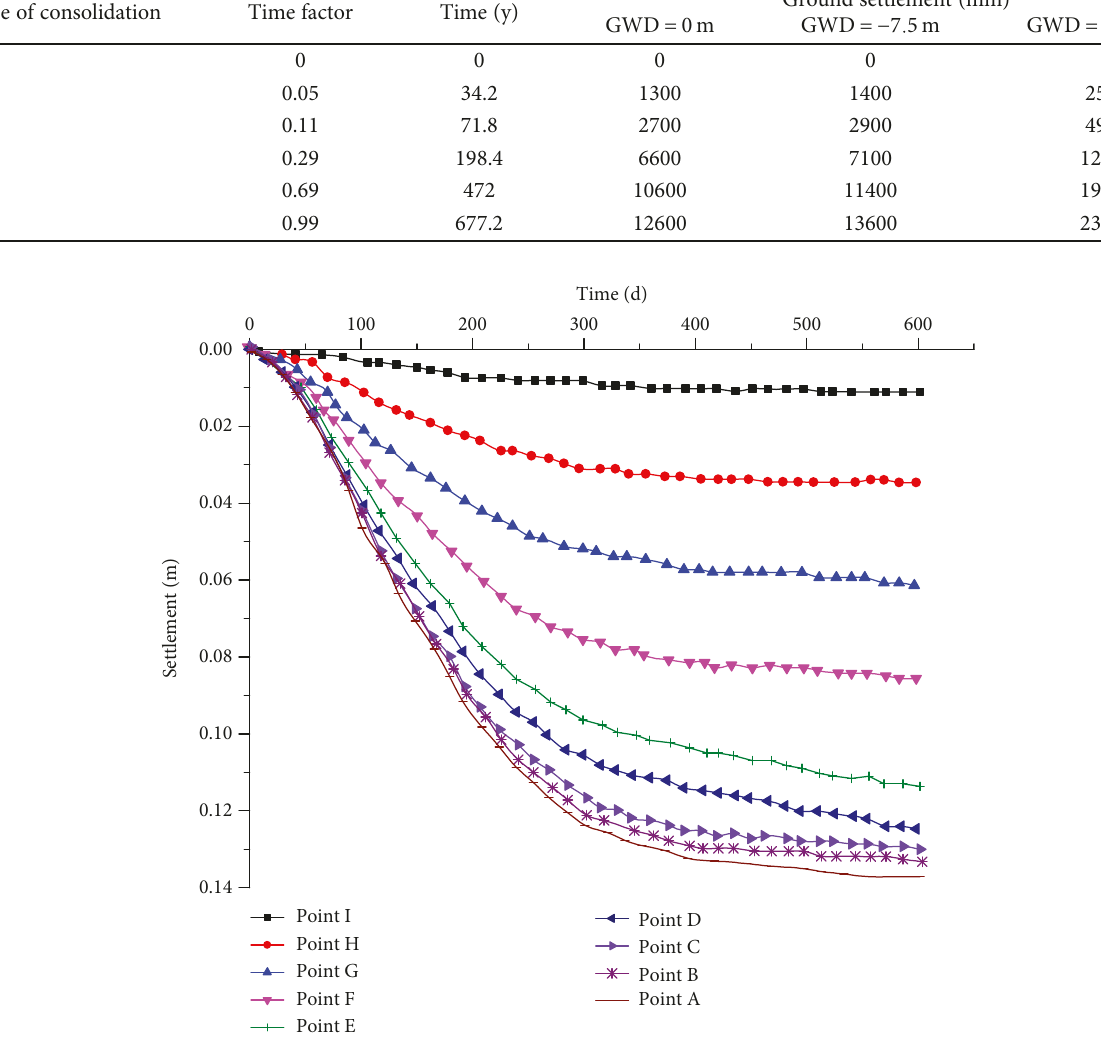
Figure 9: Ground settlement under 10 kPa uniform load